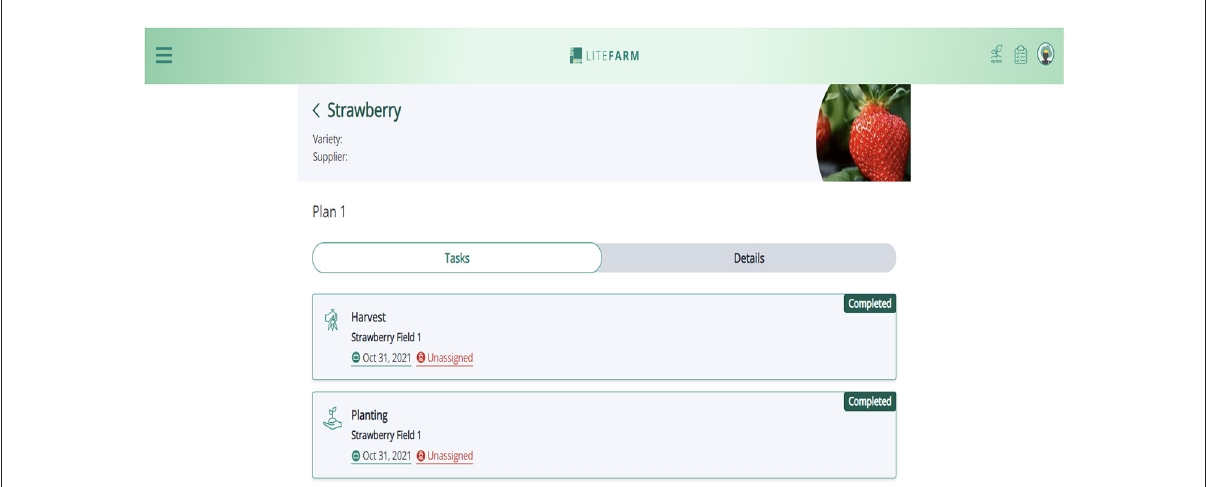
FIGURE1 This LiteFarm page depicts the planning page where farmers would add harvest logs or other actions from the fields in the farm map. This page is where the harvest logs were recorded and harvested vs. sold calculations would be manually